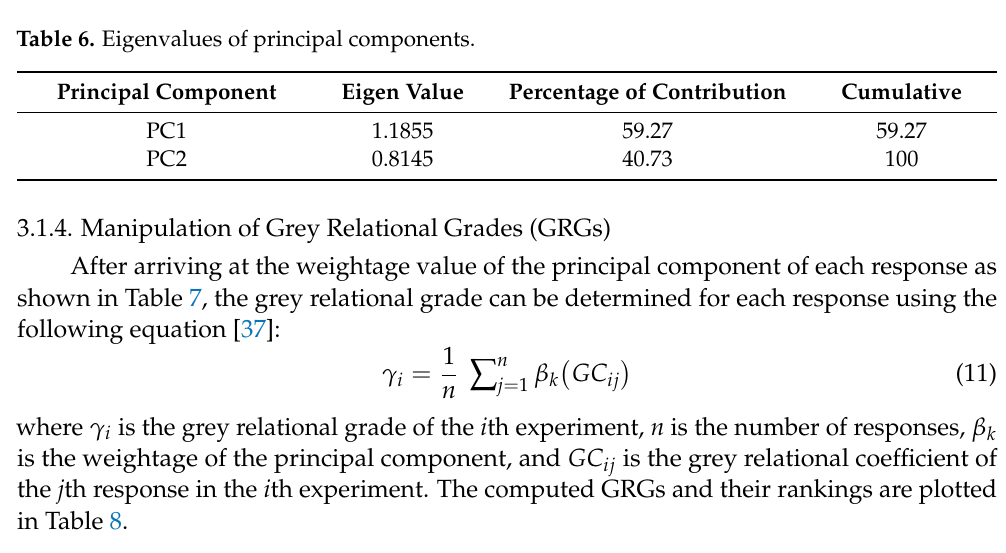
Table 7. Eigenvector value of the responses.